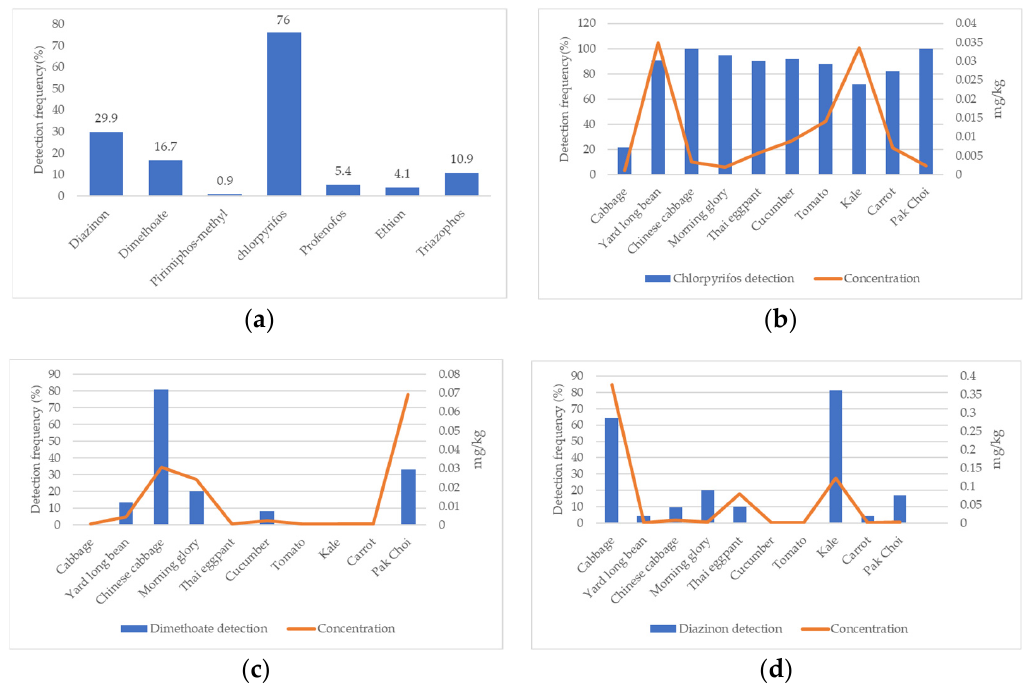
Figure 1. Detection of OPs and concentration of residues in vegetables. Detection frequency ( a ), correlation of detection and concentration of residues; chlorpyrifos ( b ), dimethoate ( c ), and diazinon ( d ).